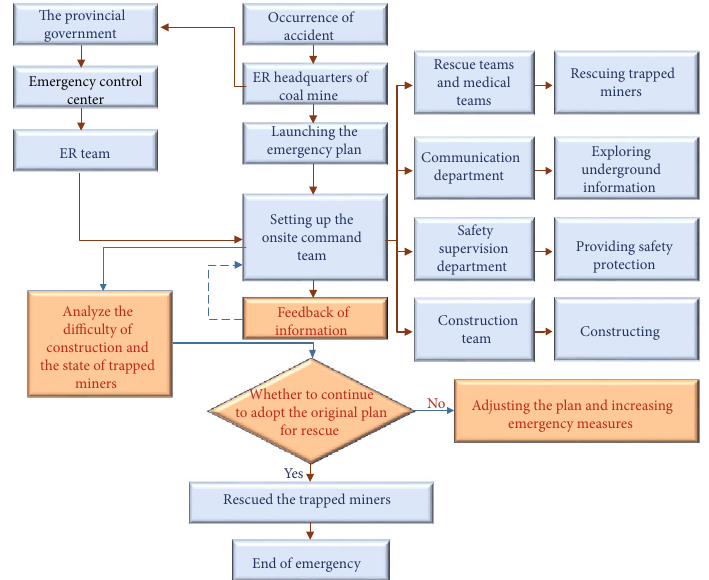
Figure 5: The ER process of the coal